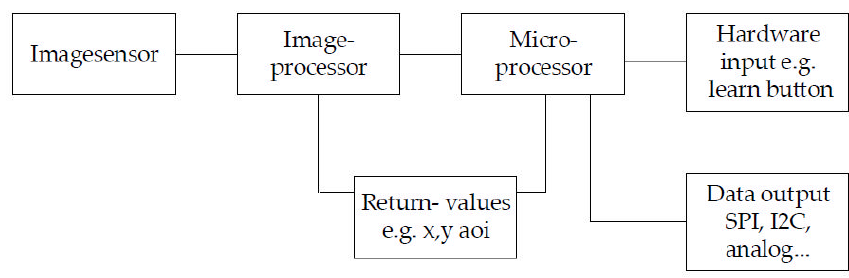
Figure 14. Schematic sensor hardware.